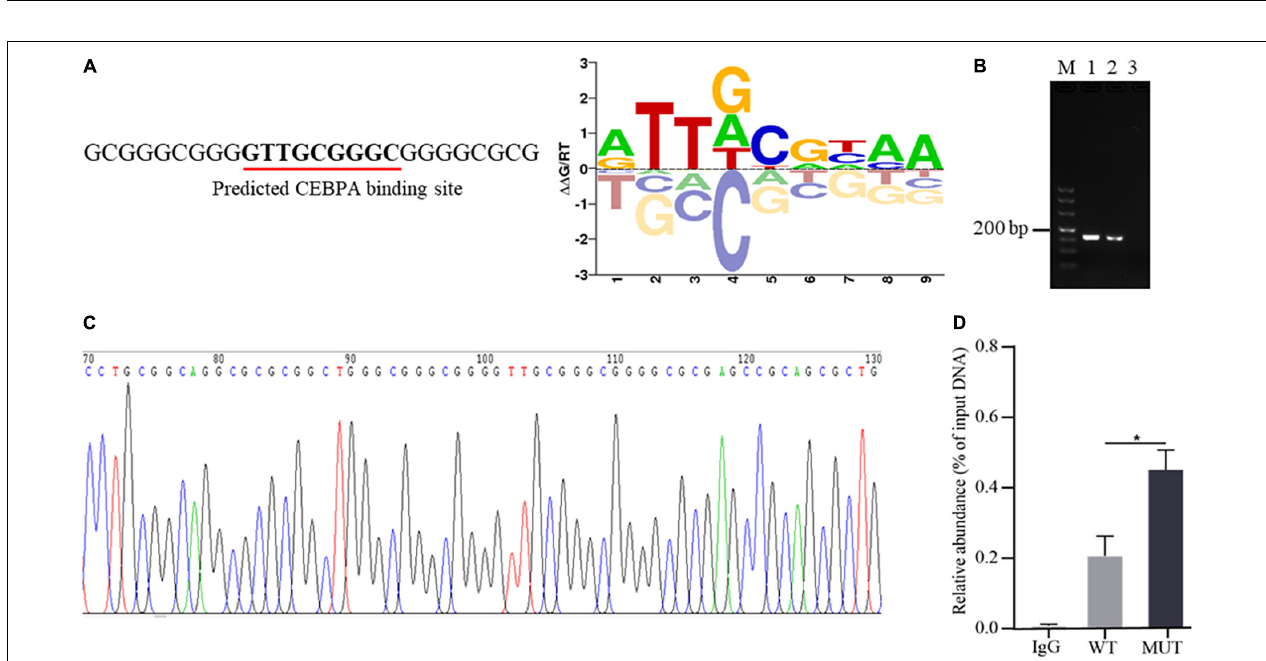
FIGURE 3 | Occurrence of the insertion mutation in AQP3 promoter promotes binding capacity of CEBPA. (A) Prediction of transcription factor binding sites based on the sequence of the insertion mutation. The predicted binding sequence is underlined. (B) ChIP-PCR of the inserted sequences analyzed by agarose gel. M: DL500 DNA marker; 1: products of input DNA sample; 2: products of IP DNA sample; 3: negative control of IgG. (C) Sequencing of PCR products for the inserted sequences. (D) Enrichment of CEBPA with wild type and mutant sequences of AQP3 promoter by ChIP-qPCR. WT, wild type sequence; MUT, mutant sequence; IgG, negative control. * P <